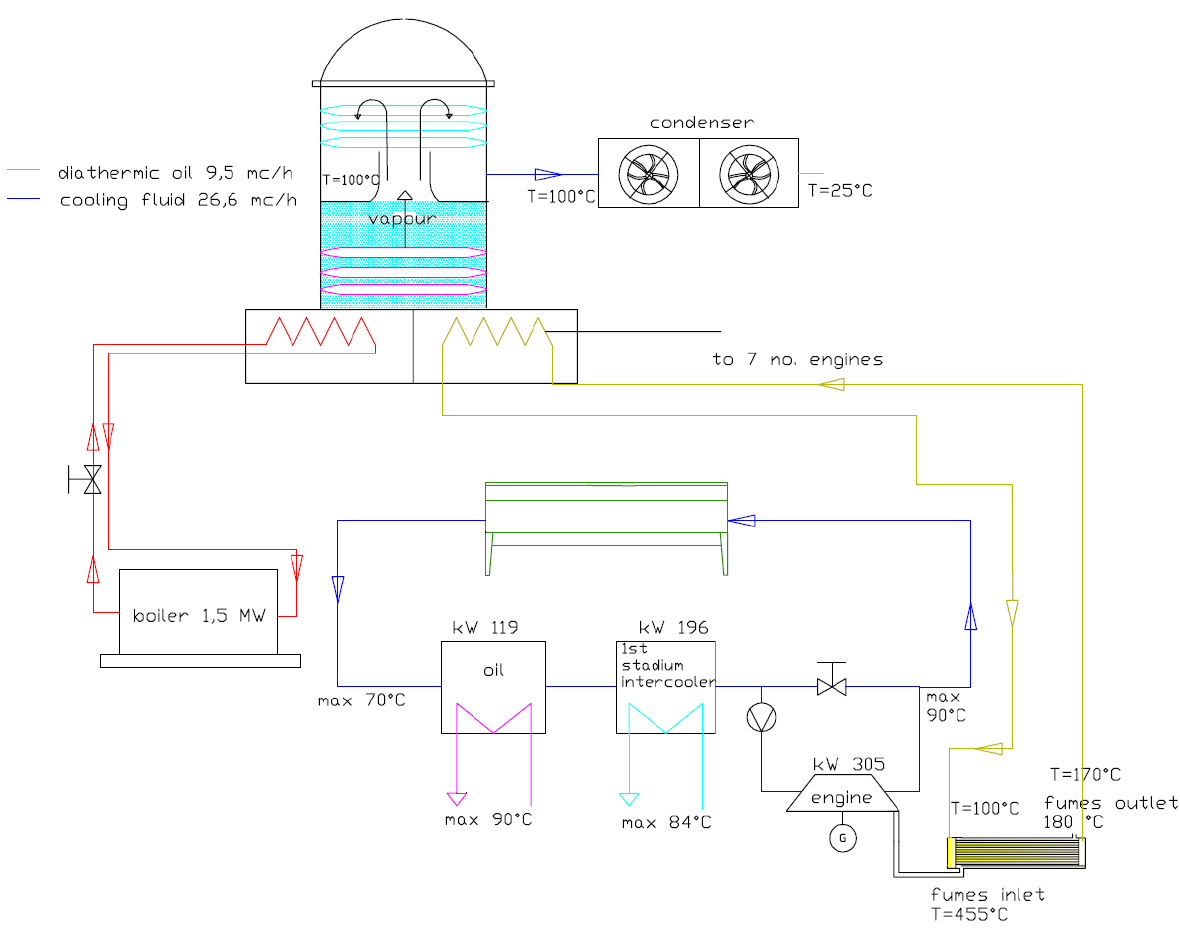
Figure 4. Unifilar diagram of the thermal power recovery plant in Scenario